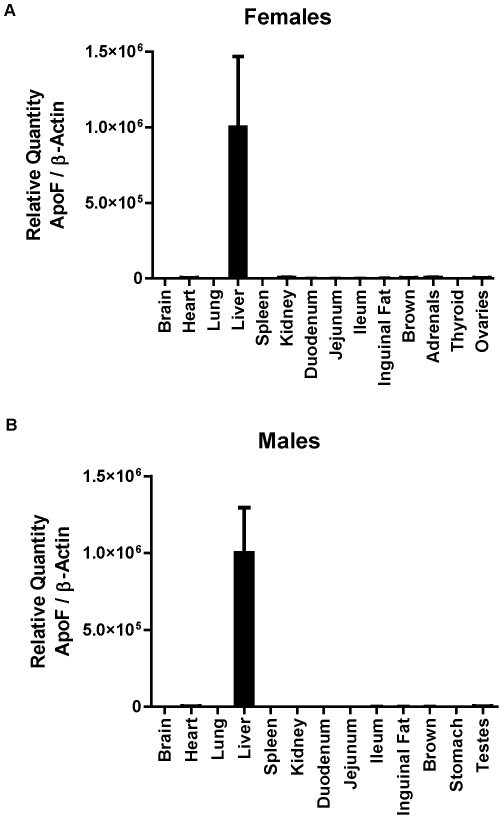
Tissue expression, processing and glycosylation of murine apolipoprotein F.
A. Real time RT-PCR analysis of total RNA from tissues of female mice: brain, heart, lung, liver, spleen, kidney, duodenum, jejunum, ileum, inguinal fat, brown fat, adrenals, thyroid, and ovaries. B. Real time RT-PCR analysis of total RNA from tissues of male mice: brain, heart, lung, liver, spleen, kidney, duodenum, jejunum, ileum, inguinal fat, brown fat, stomach and testes. Values are shown as the mean +/− standard deviation for each animal (n = 3 per group).